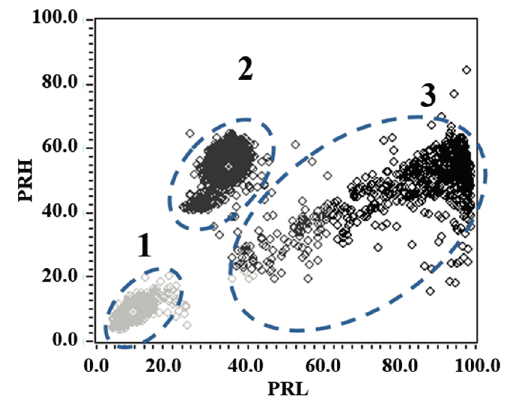
Figure 14. PR map for simultaneous PD and noise activity. Frequency intervals for